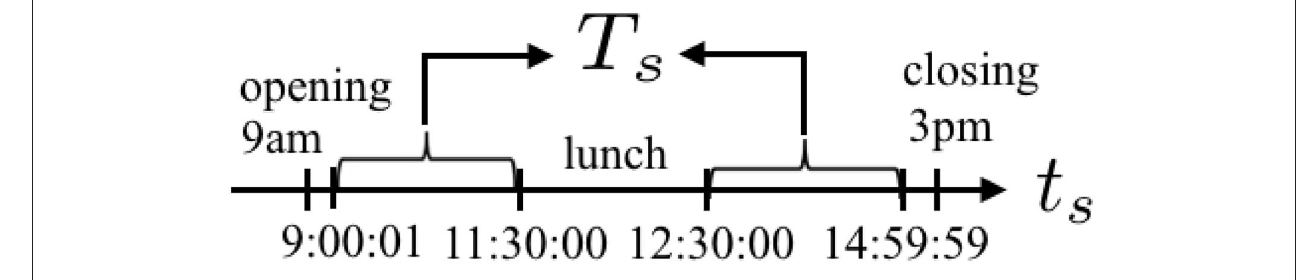
FIGURE 7 | Illustration of T s .